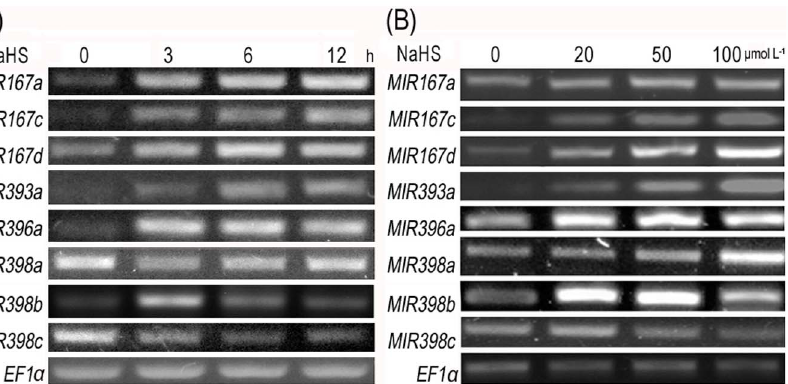
Figure 3. NaHS effects on miRNAs expression in WT seedlings. ( A ) miRNAs expression in WT seedlings treated with 50 m mol L 2 1 NaHS for 0, 3, 6, 12 h; ( B ) miRNAs expression in WT seedlings treated with 0, 20, 50, 100 m mol L 2 1 NaHS for 12 h. EF1- a was used as an internal control.